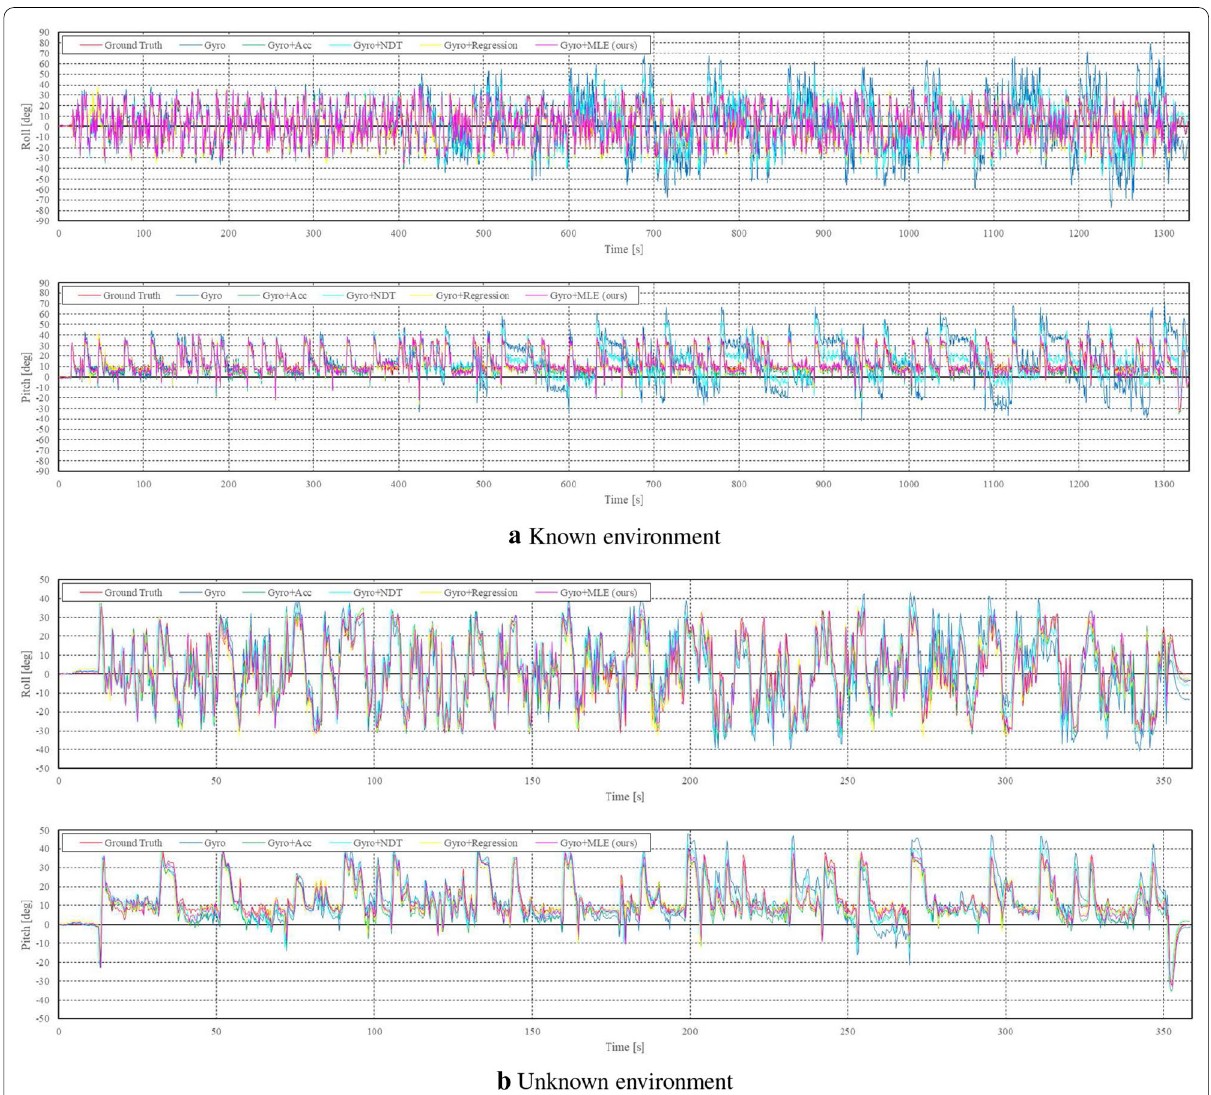
Fig. 12 Real-time attitude plotting. In ( a ), the result of the flight in “Neighborhood” is shown. In ( b ), the result of the flight in “SoccerField” is